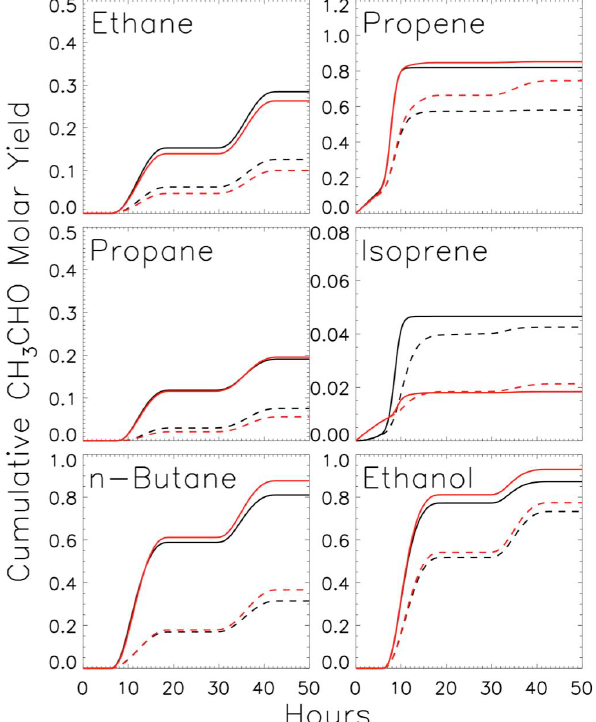
Fig. 3. Cumulative molar yield of acetaldehyde from the oxida- tion of VOCs. Yields are computed using the GEOS-Chem (red) and MCMv3.1 (black) chemical mechanisms, for 1ppb NO x (solid lines) and 0.1ppb NO x (dashed lines).